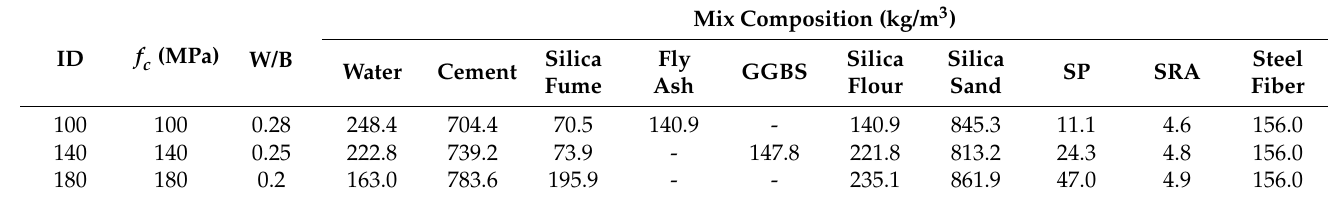
Table 1. Mix proportions of the specimens.